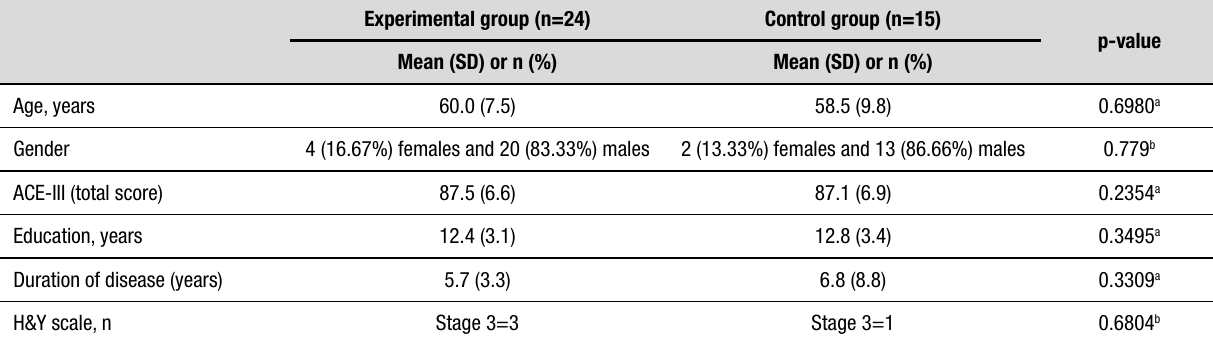
Table 1. Demographic and clinical data at baseline of patients in the control and experimental